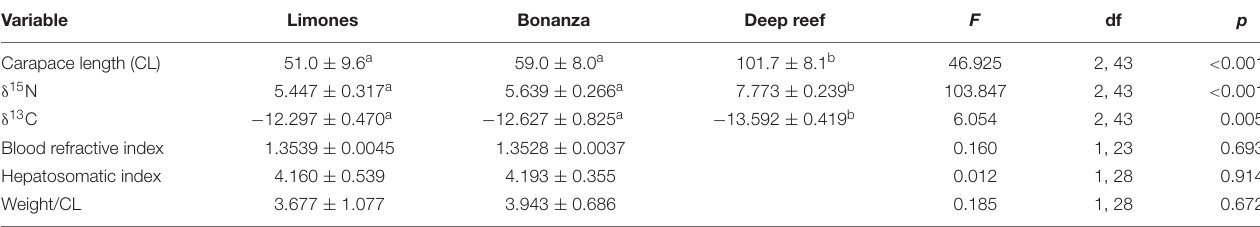
TABLE 5 | Results of General Linear Models testing for effects of reef habitat (Limones, Bonanza, and the deep reef) on main response variables of Panulirus argus . Variable